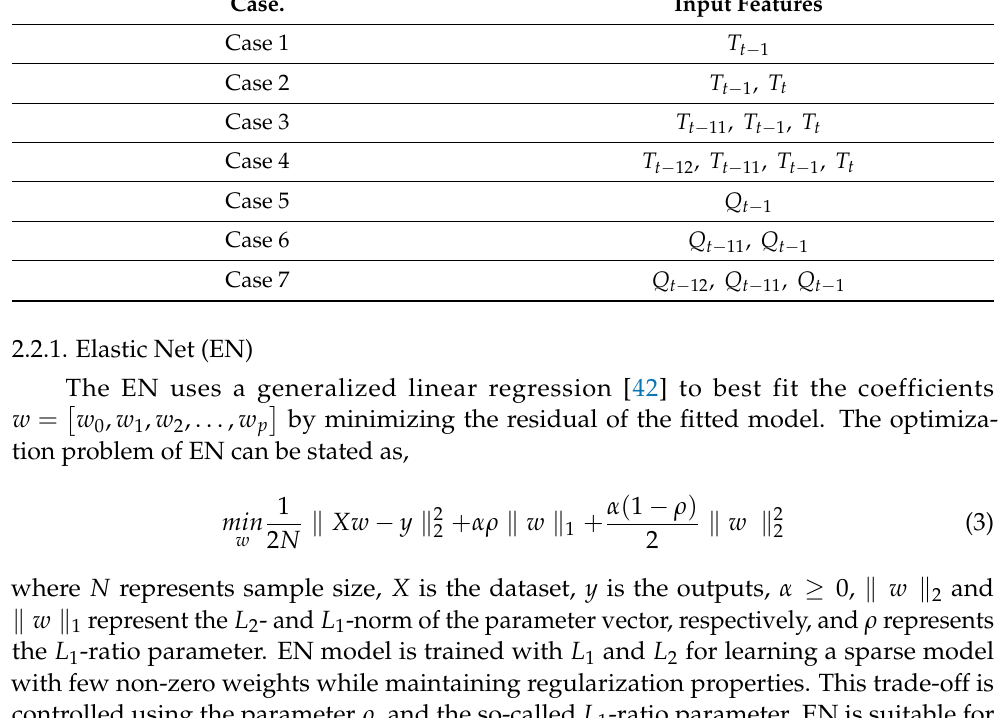
Table 2. Input features associated with models tested in this paper. Case.